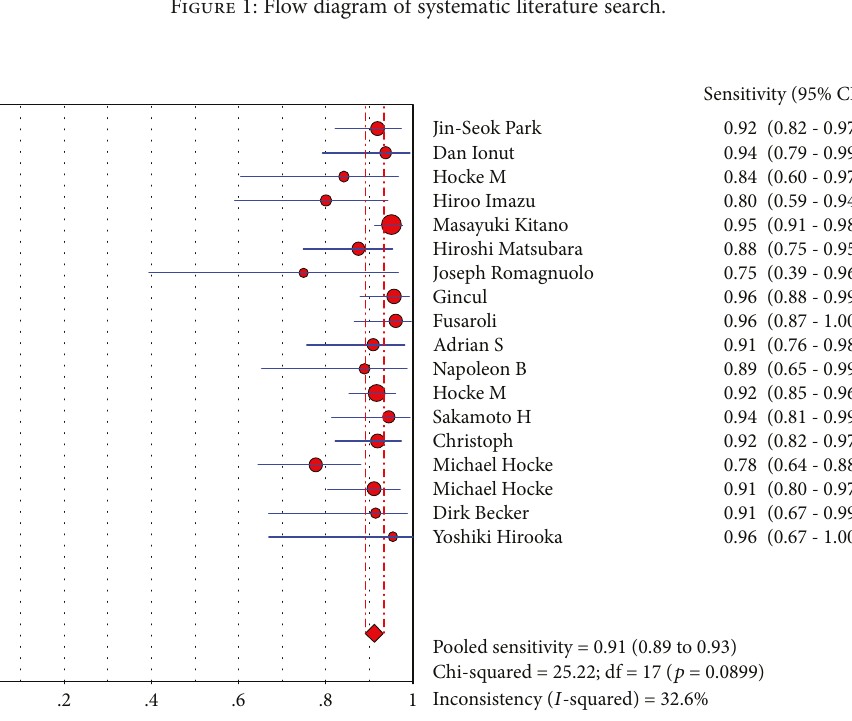
Figure 1: Flow diagram of systematic literature search.